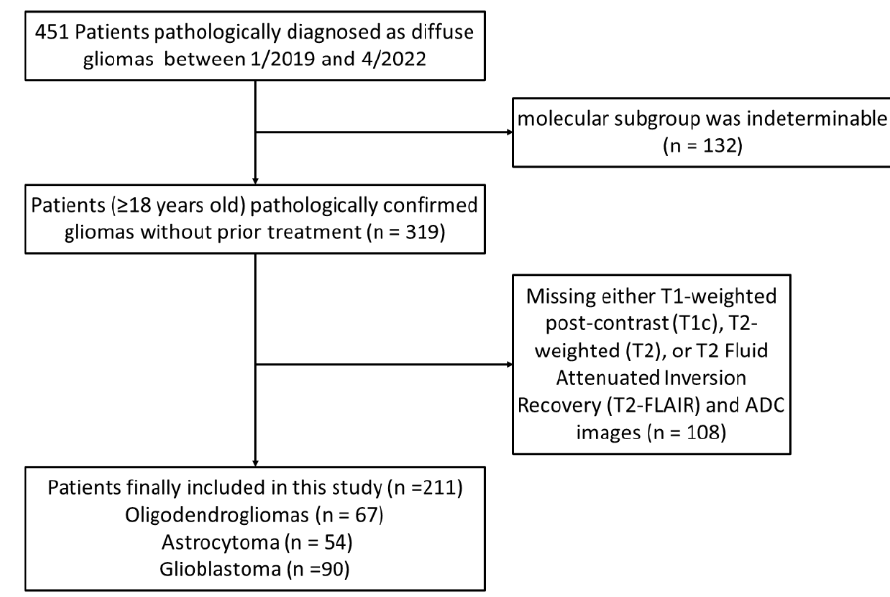
Figure 1. Flowchart depicting patient inclusion and exclusion criteria.